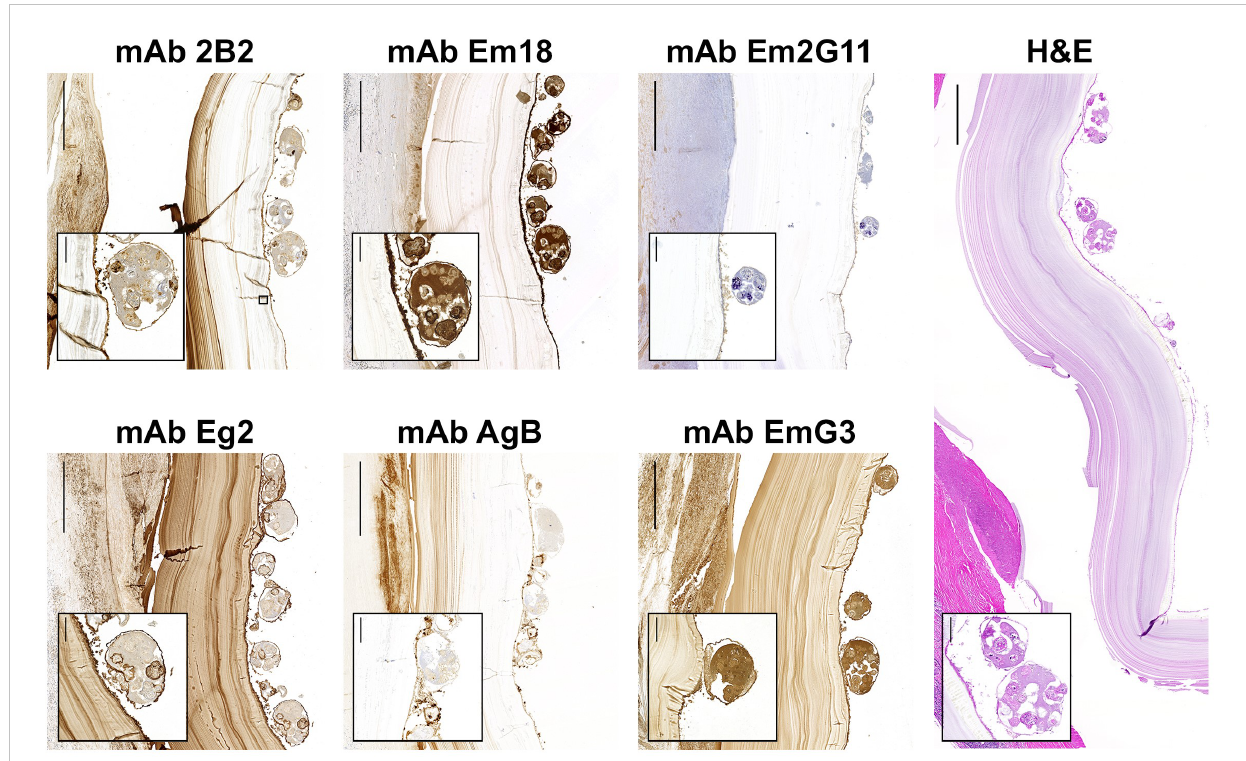
FIGURE 2 Immunohistochemical stainings (IHC-S) with mAbs on liver sections of a patient with cystic echinococcosis. H&E, haematoxylin and eosin staining. Scale bars: 1 mm; insets: 100 m m. The enlarged sections are brood capsules of E. granulosus s.l. , surrounded by a germinal layer. A positive staining is connected to a strong brownish